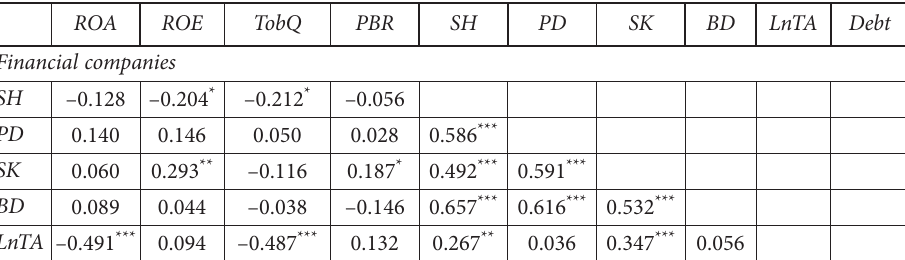
Table 4. Spearman correlation